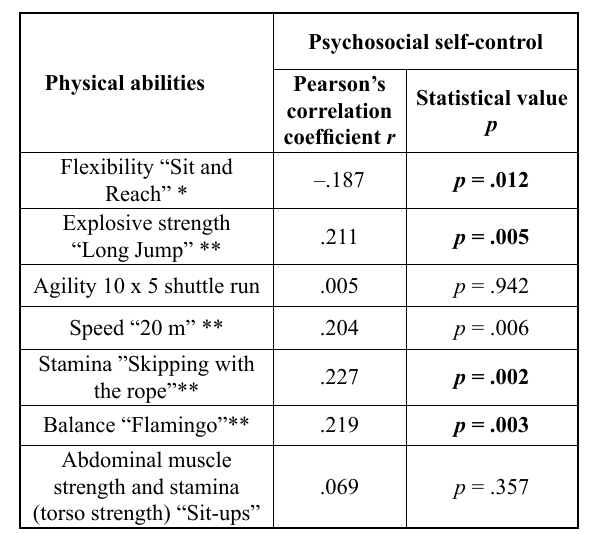
Table 3. Correlations between pupils’ physical and psychosocial self-control abilities